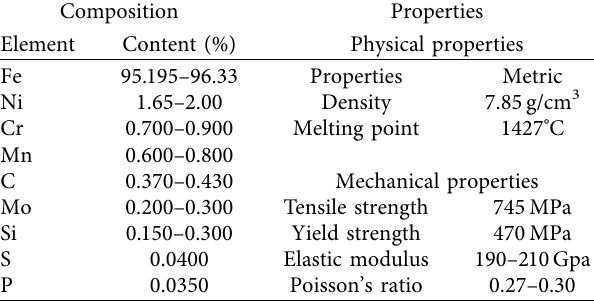
Table 1: The composition and properties of AISI 4340